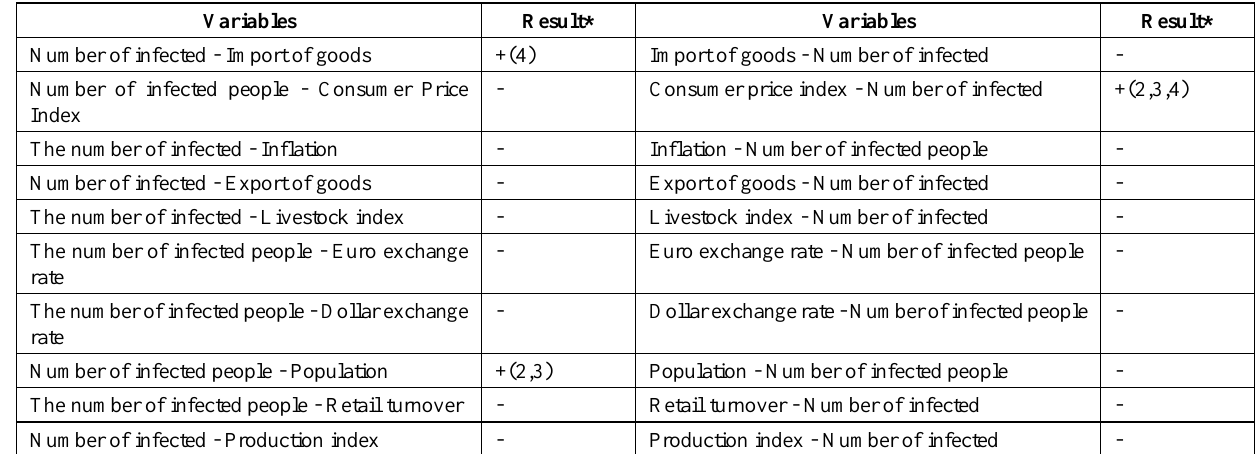
Table 2. Results of applying the Granger